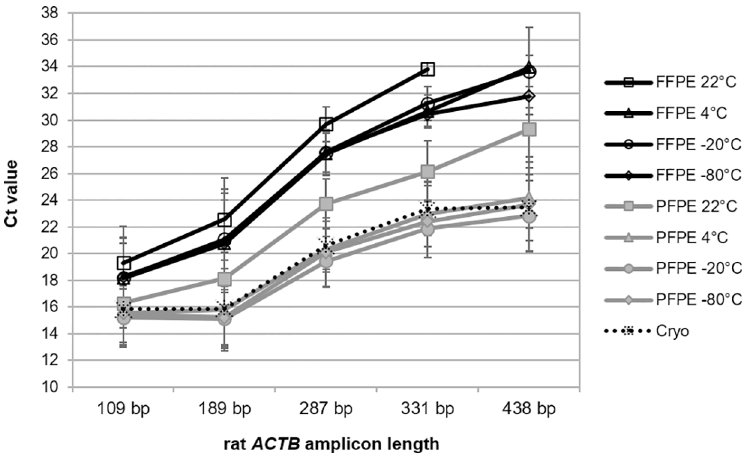
Fig 6. Improved RT-qPCR-performance of RNA from rat tissue blocks stored at 4˚C or frozen for 9 years. PFPE and FFPE tissues were stored 108 months (m) at different temperatures (22˚C, 4˚C, -20˚C, and -80˚C). Reverse transcription and amplification in five different rat ACTB SYBR-Green RT-qPCR assays ranging from 109 to 438 base pairs (bp). Mean Ct values with standard deviation from triplicate extractions from each of five different tissues (liver, kidney, spleen, lung and intestine) are shown for each assay. RNA from cryo preserved tissue was used as a reference, shown as dashed line.